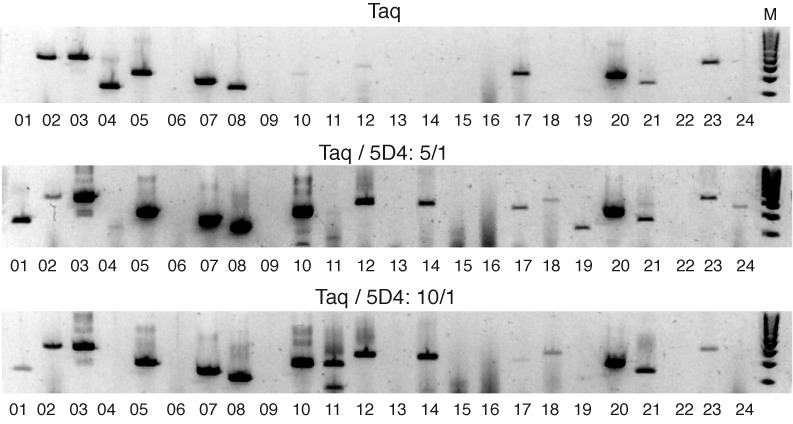
Amplification of 24 individual human genomic loci. Comparison of PCR performance of Taq (top) panel, with two different Taq/5D4 blends (5/1 (middle panel); 10/1 (bottom panel)) on the amplification of 24 different promotor regions in bisulfite-treated and fully desulphonated human genomic DNA. Both blends are able to amplify a significantly larger number of loci than Taq alone and together enable amplification of 18 out of 24 loci (75%).